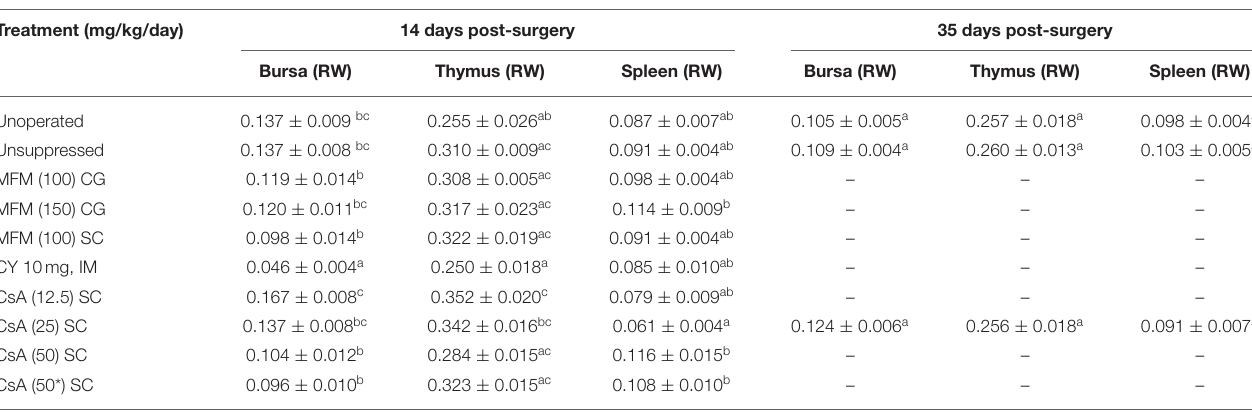
TABLE 4 | Bursal, thymic, and splenic relative weights (%), from Study 2 and 3. Treatment